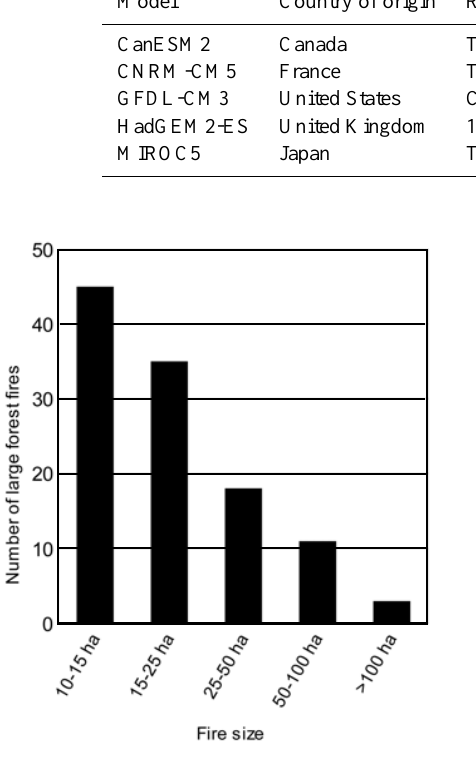
Figure 1. Large forest fires in Finland during 1996–2014 as classi- fied on the basis of fire